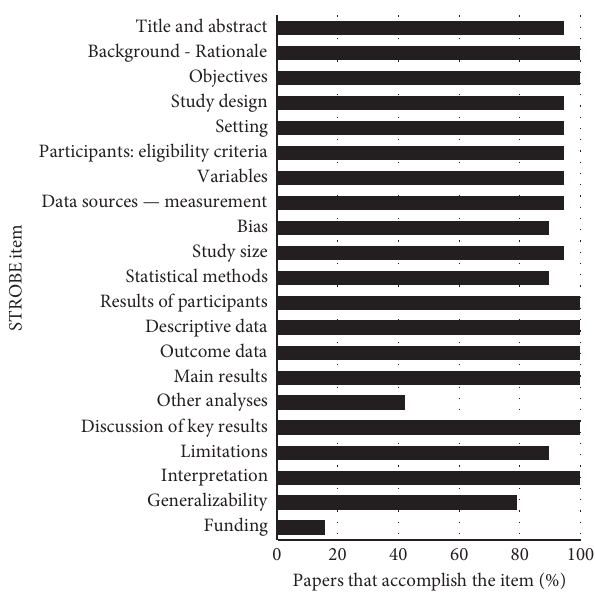
Figure 2: Evaluation of methodological